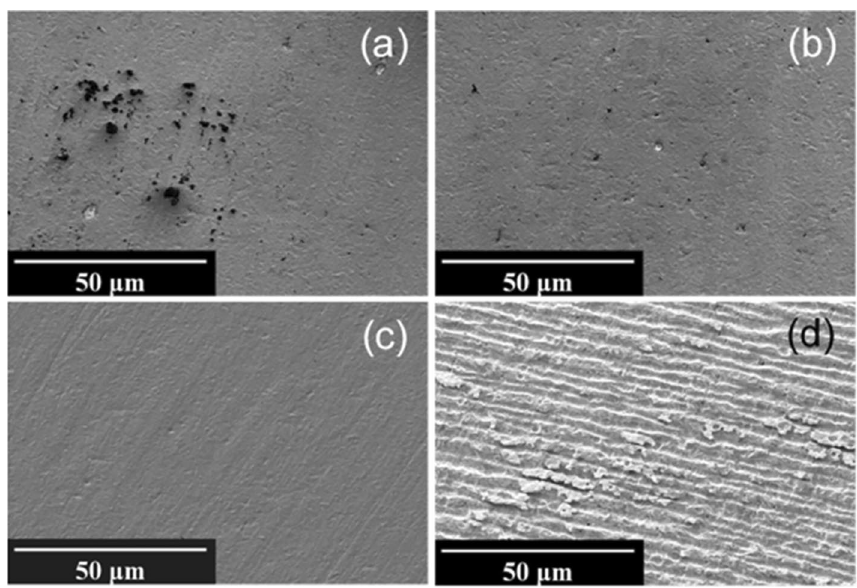
Figure 6. Scanning electron micrographs of PCB surfaces ( a ) Uncleaned, ( b ) UV-O 3 , ( c ) KOH + H 2 O 2 , ( d )